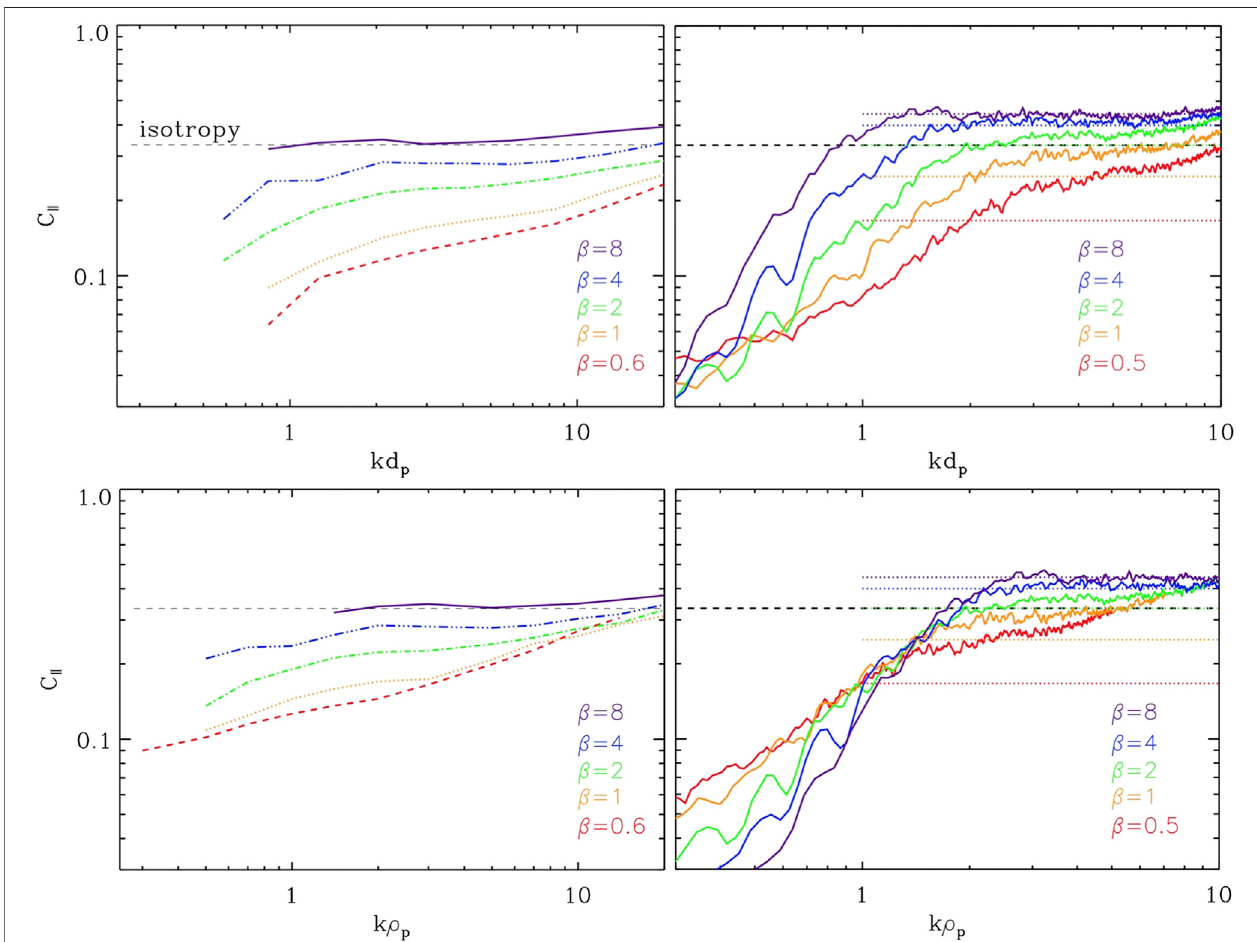
FIGURE 9 | Top panels (left): Cluster spectra of magnetic compressibility for intervals binned on different β , encoded in different styles and colors. Only cases with β ∼ β p e have been retained. The horizontal dashed line denotes energy equipartition between components (i.e., isotropy). Right: spectra of magnetic compressibility for simulationswithdifferent β p (cid:2) β e ,shownwiththesamestyleastheleftpanel.Theincreaseof C (cid:3) for kd i T 8isduetonumericalnoise.Bottom:thesameastoppanels,but withk-vectors normalized with respect tothe ion gyroradius ρ p . Horizontal dotted lines,colored according totheir β , arethe theoretical prediction of C (cid:3) from Eq. 2